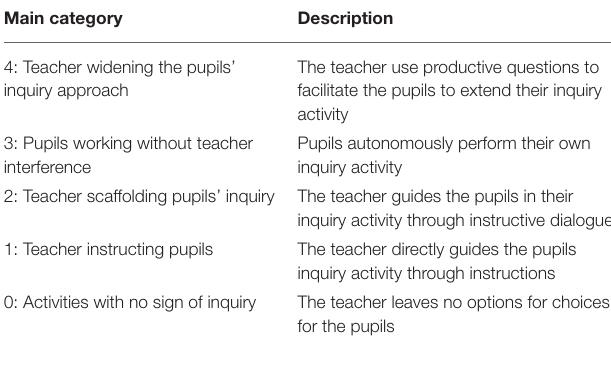
TABLE 2 | Overview of analytic categories.